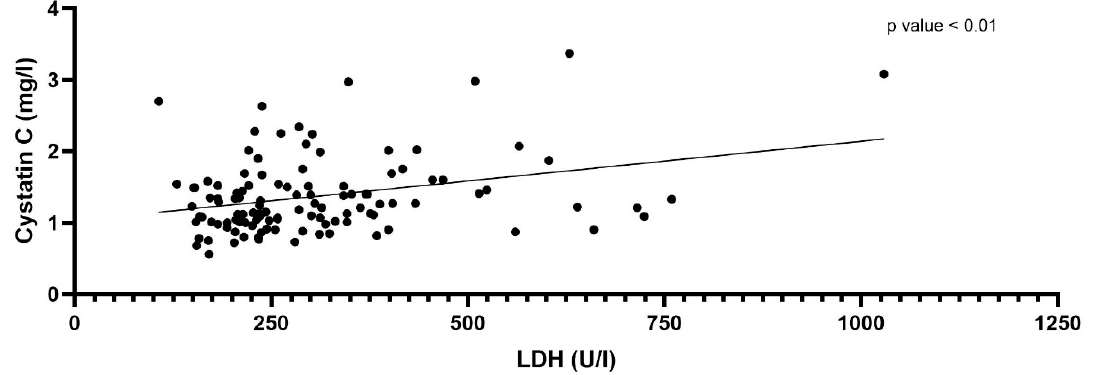
Figure 4. Spearman ( ρ ) correlation coefficient between LDH and Cystatin C ( p < 0.01, r = 0.239, n = 120).